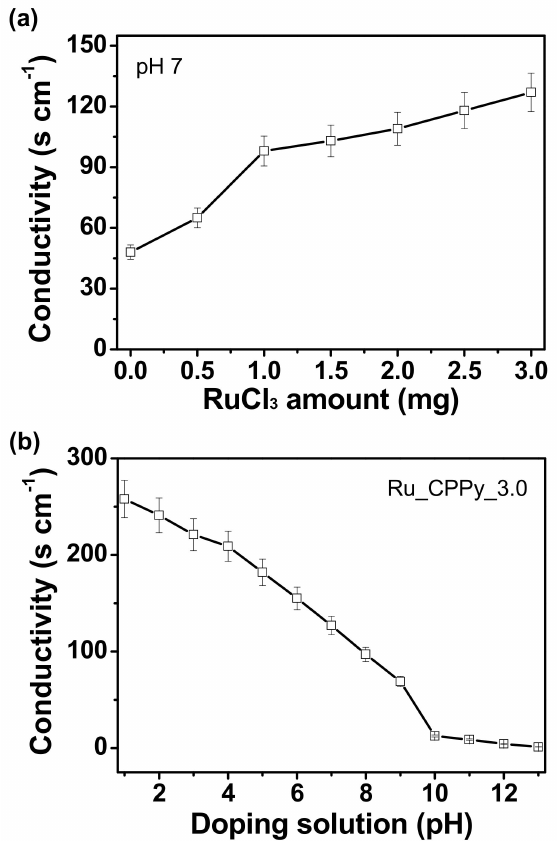
Figure 4. The electrical conductivities of ( a ) di ff erent CPPyNP-based nanoparticles with diverse RuCl 3 concentrations with a pH of 7 and ( b ) Ru_CPPy_3.0 with various pH values in a chemical